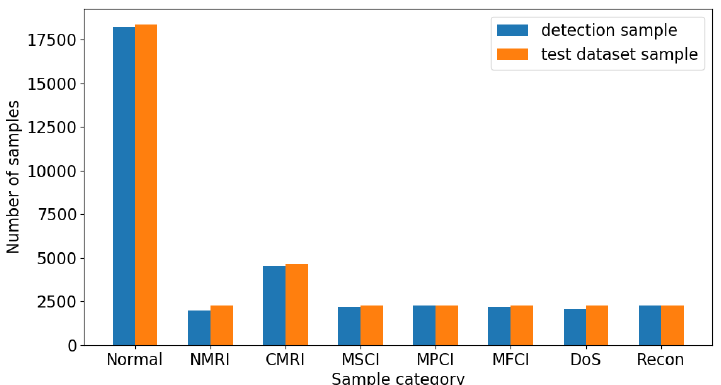
Figure 6. Detection results on the test set.